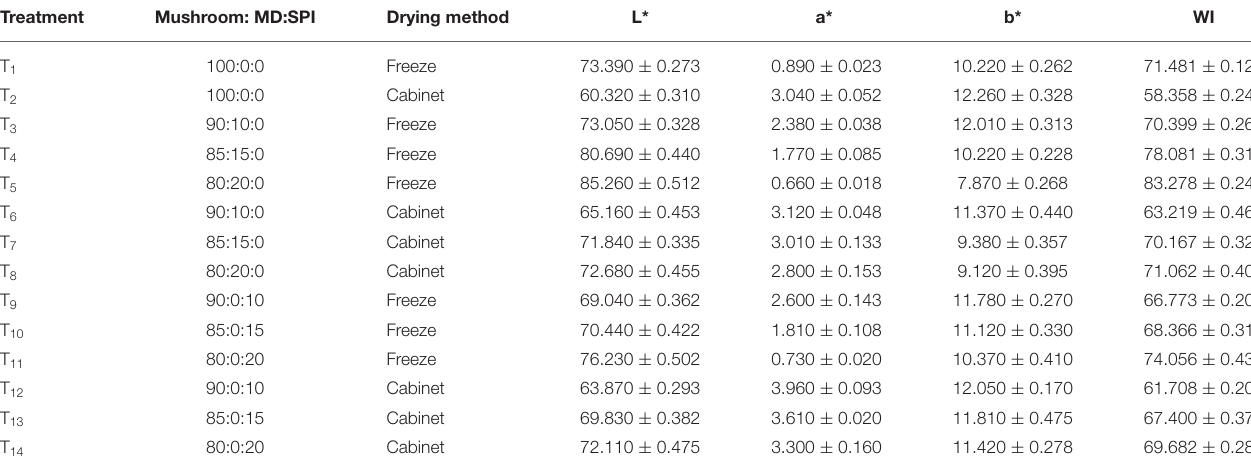
TABLE 4 | Color parameters of BMP.